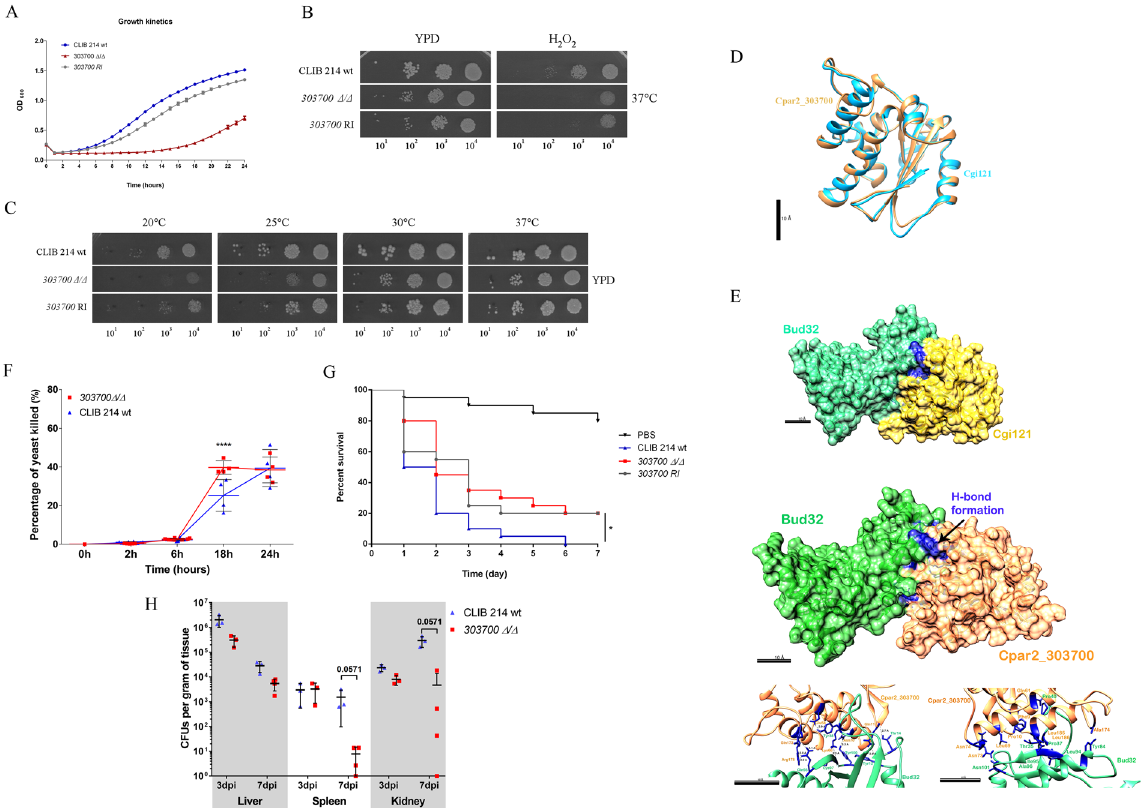
Figure 6. Phenotypic features of the CPAR2_303700 Δ / Δ strain. ( A ) Growth kinetics of wild-type (CLIB 214), CPAR2_303700 Δ / Δ and CPAR2_303700 reintegrant (RI) strains in YPD liquid medium, at 30 °C. ( B ) Growth on 10 mM H 2 O 2 supplemented YPD medium, and ( C ) on YPD solid medium at different temperatures. ( D ) In silico 3D structure comparison of the hypothetical Cpar2_303700 and the previously described S. cerevisiae Cgi121 proteins. Scale bar: 10 ångström (Å). ( E ) 3D structure of the complex formed by Cpar2_303700 and Bud32 and its comparison to the Cgi121-Bud32 complex. Predicted H-bonds (bottom left) and the surrounding hydrophobic residues (bottom right) maintain the stability of the Cpar2_303700 – Bud32 complex. Moderately attenuated virulence of CPAR2_303700 Δ / Δ ( F ) in vitro after J774.1 macrophage infection, following ( G ) G. mellonella larvae inoculation and ( H ) BALB/c mice infection. Statistical significance was determined by two-way ANOVA and Dunnett’s multiple comparisons tests in case of J774.1, unpaired Mann-Whitney tests in case of BALB/c mice infection and Mantel-Cox (Log-rank) test after G. mellonella infection: * p ≤ 0.05; **** p ≤